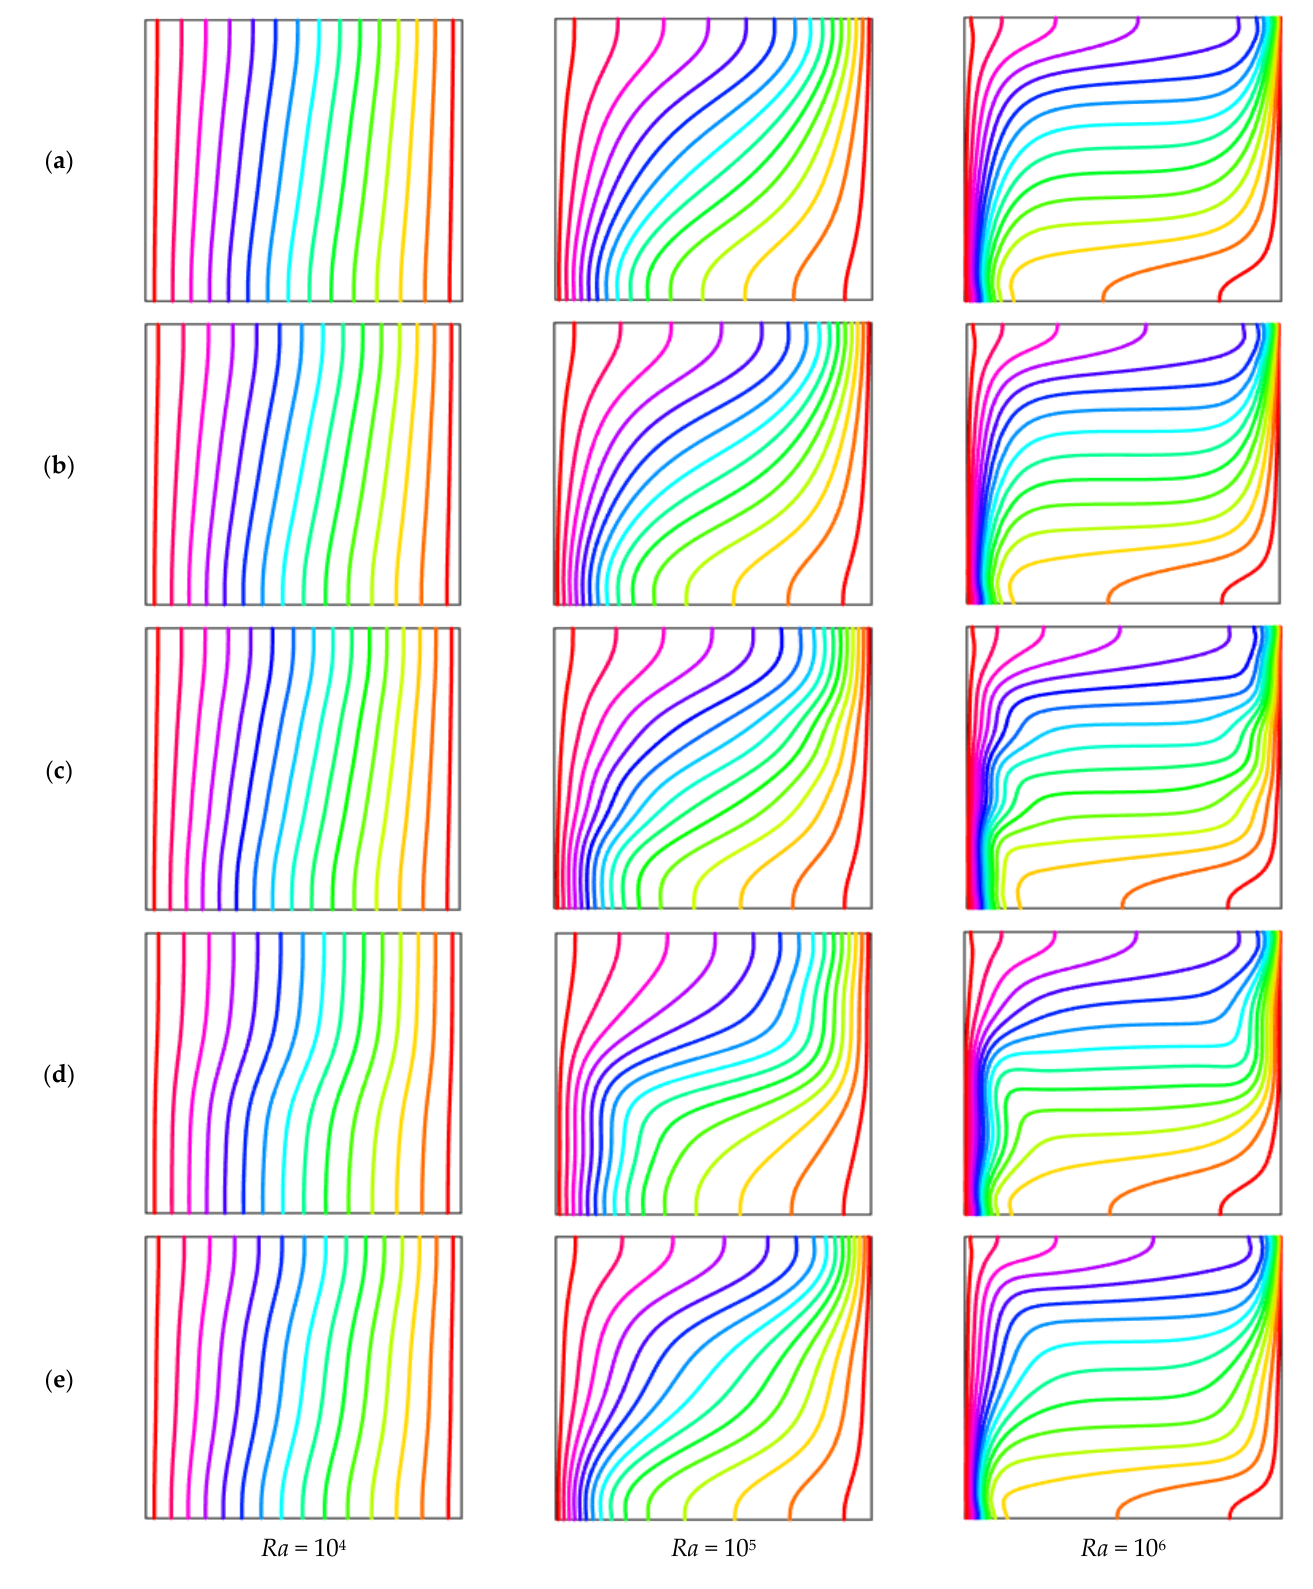
Figure 6. Effect of isotherms for various Rayleigh number ( Ra ) for ( a ) uniform magnetic field (umf), ( b ) λ = 0.1, ( c ) λ = 0.25, ( d ) λ = 0.5, and ( e ) λ = 1 when Ha = 30, d = 10 nm, ϕ = 0.04, n = 3, Pr = 6.8377, and τ = 1.